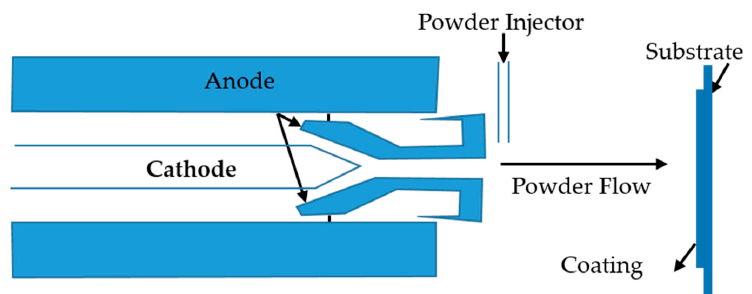
Figure 3. Simplified Overview of Plasma Spraying Process [116].